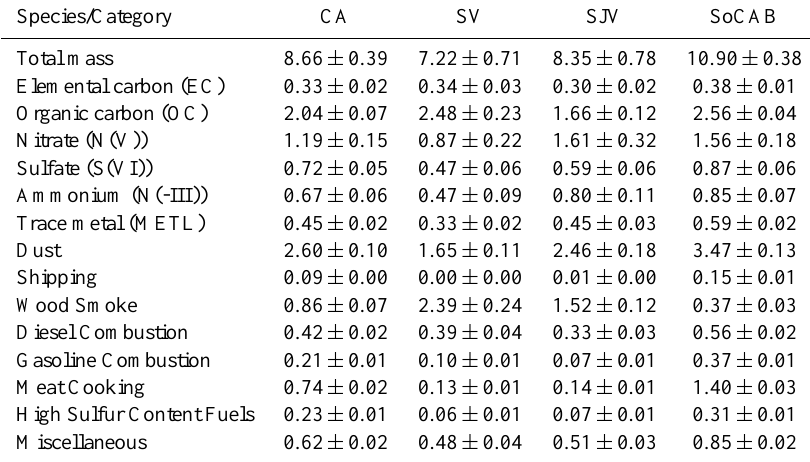
Table 1. Population-weighted annual average concentrations (µgm − 3 ) of PM 2 . 5 total mass, major component species, metal and sources contributing to total primary mass for the present-day (2000–2006) for California (CA), and three air basins: Sacramento Valley (SV), San Joaquin Valley (SJV) and South Coast Air Basin (SoCAB). The error shown is one standard